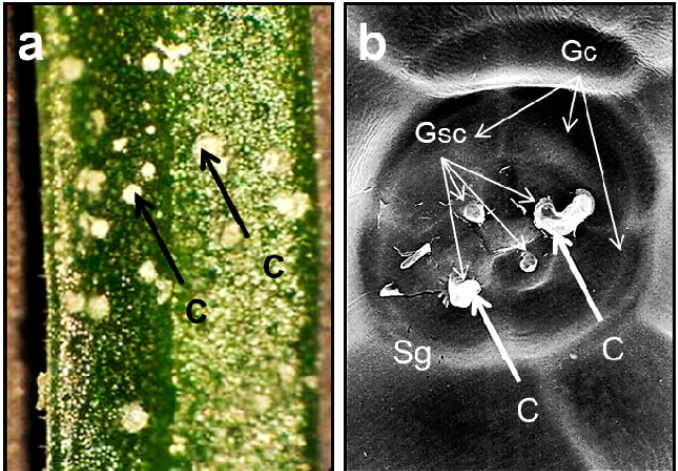
Figure 2. Leaf area of A. maritima after four months of culture in medium supplemented with 20 mM lead nitrate: ( a ) crystals on the leaf, magnification 25×; ( b ) salt glands among the cells of the epidermis cells; scanning electron microscope, magnification 2000×. Abbreviations: C—salt crystal; Gc—cells of the gland; Gsc—secretory cells of the gland; Sg—salt gland. All photos by Agnieszka Abratowska (based on Abratowska et al., 2015 [47], modified).